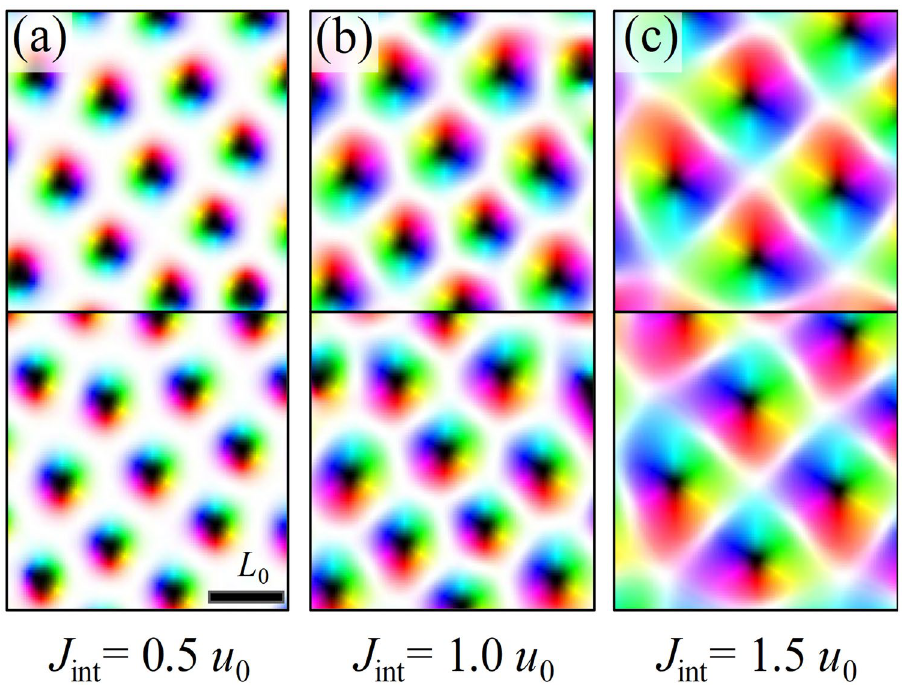
Figure 5. ( a – c ) Magnetic structures for the case of h = u 0 and | J int | = 0.5 u 0 , u 0 , 1.5 u 0 . The top figures of ( a – c ) represent the structures of the layer 1, and the bottom figure represents those of the layer 2. Skyrmion lattices appear in the